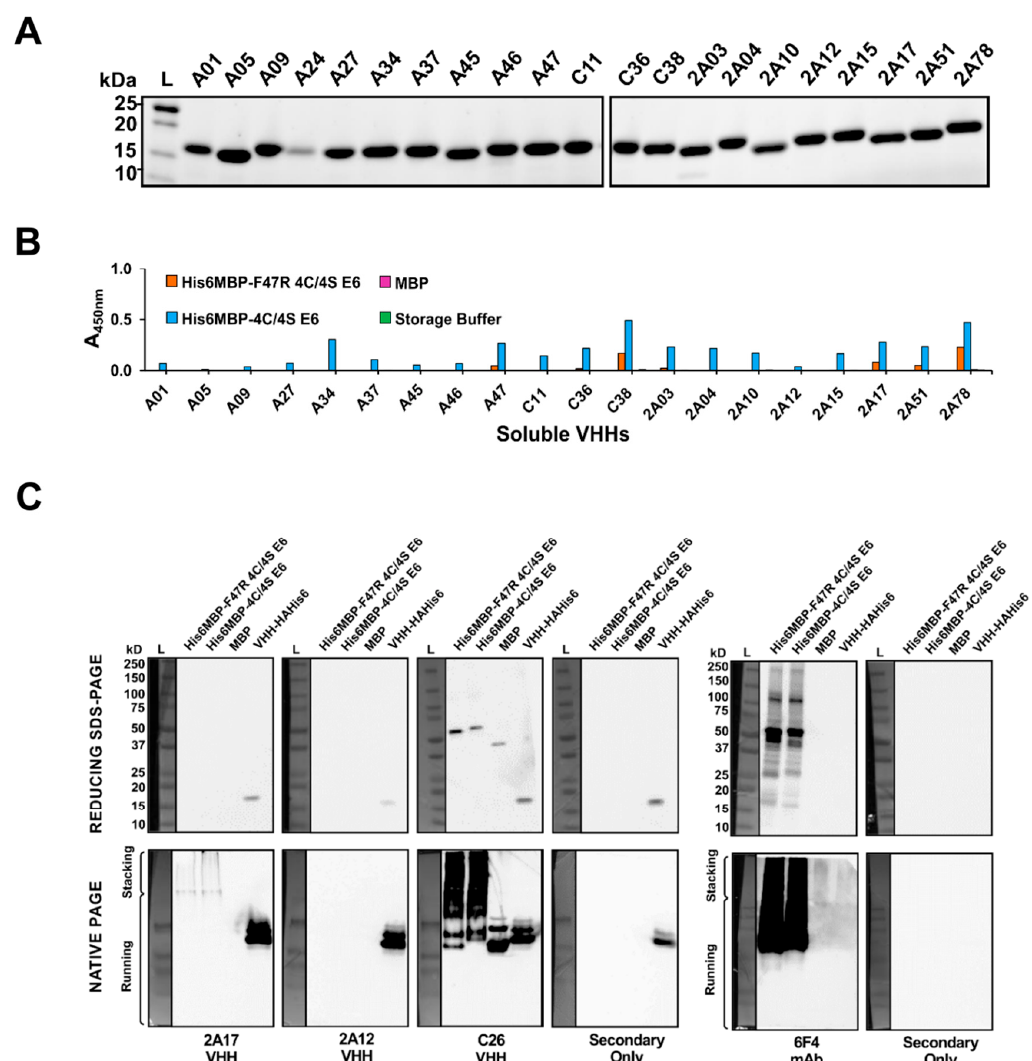
Figure 4. VHH purification and determination of their ability to detect recombinant HPV16 E6. ( A )